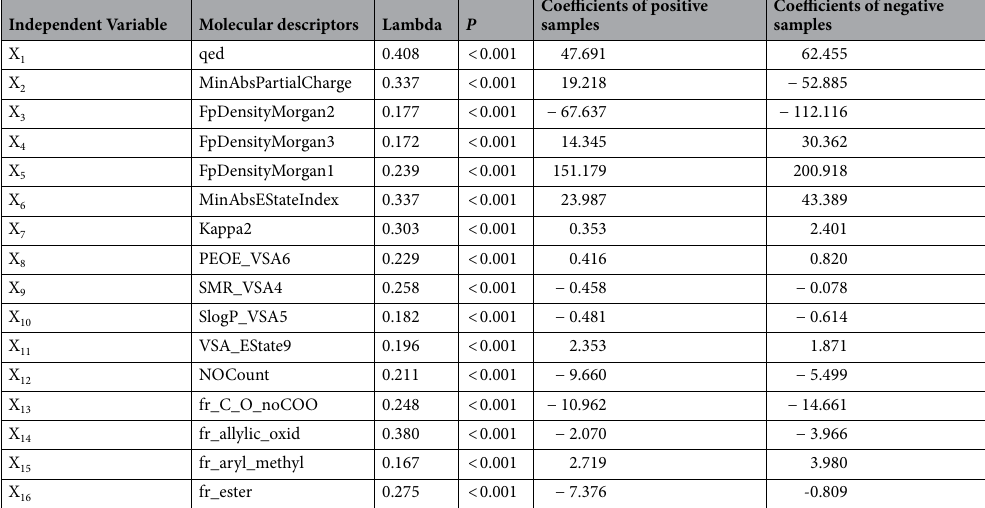
Table 2. Results of discriminant analysis.